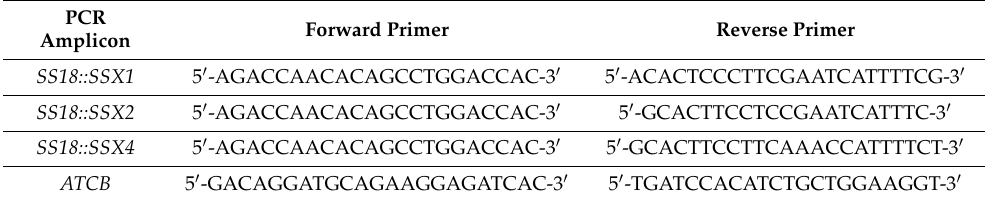
Table 1. Primer sequences for SS18::SSX and ACTB .